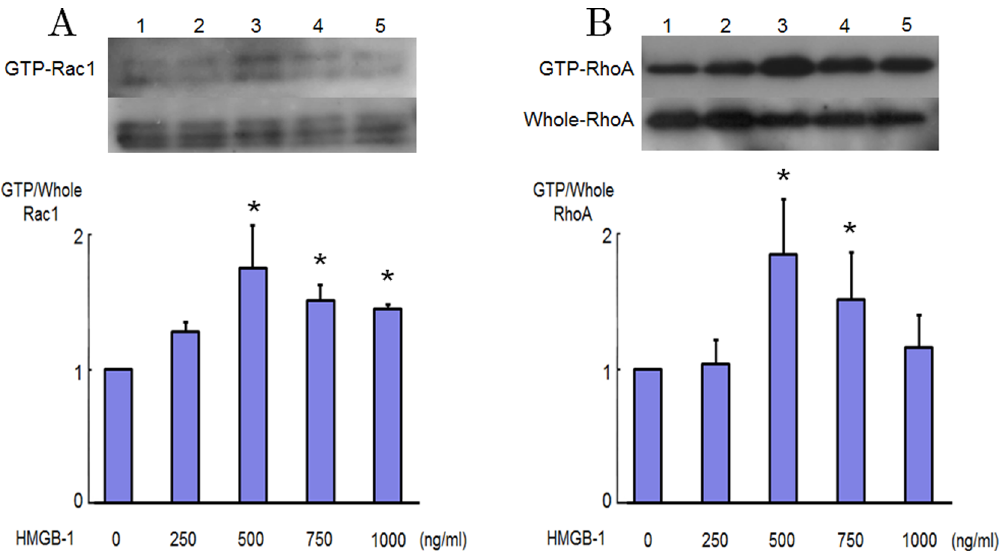
Fig. 1. RhoA and Rac1 activation stimulated by HMGB-1 in endothelial cells. Levels of GTP-bound active forms of RhoA and Rac1 as determined by pull-down assays in cultured human aortic endothelial cells (HAECs) stimulated by 250 to 1000 ng/ml HMGB-1. Bars are mean ¡ S.D. of quantitative densitometric analyses from 3 separate experiments. Representative immunoblots from 3 separate experiments are shown. * P , 0.05 vs. Lane 1.